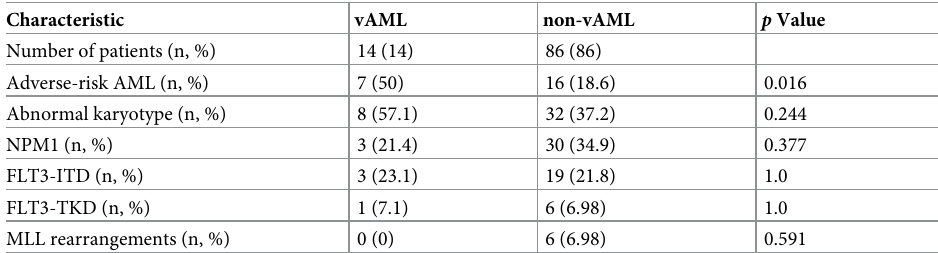
Table 3. Molecular and cytogenetic